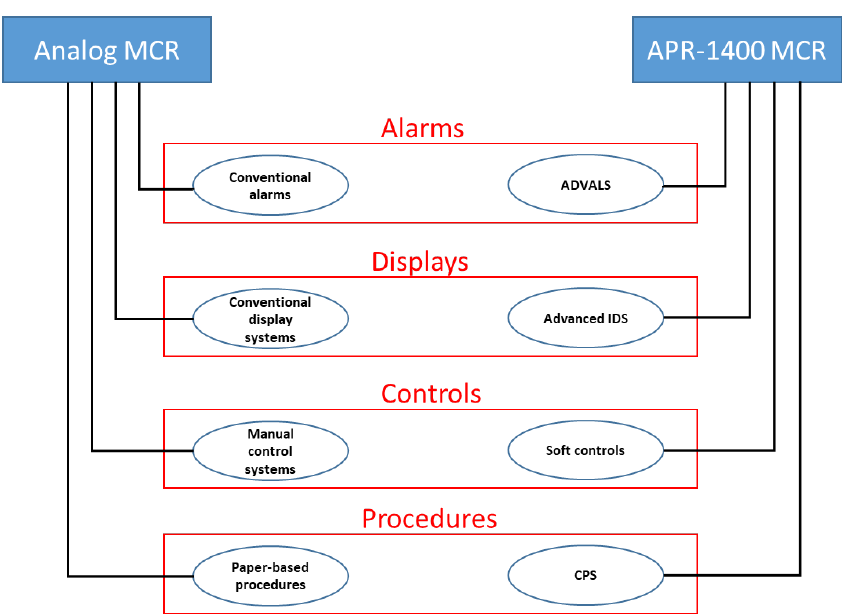
Figure 1. Distinctive features of the APRMCR versus analog MCRs.